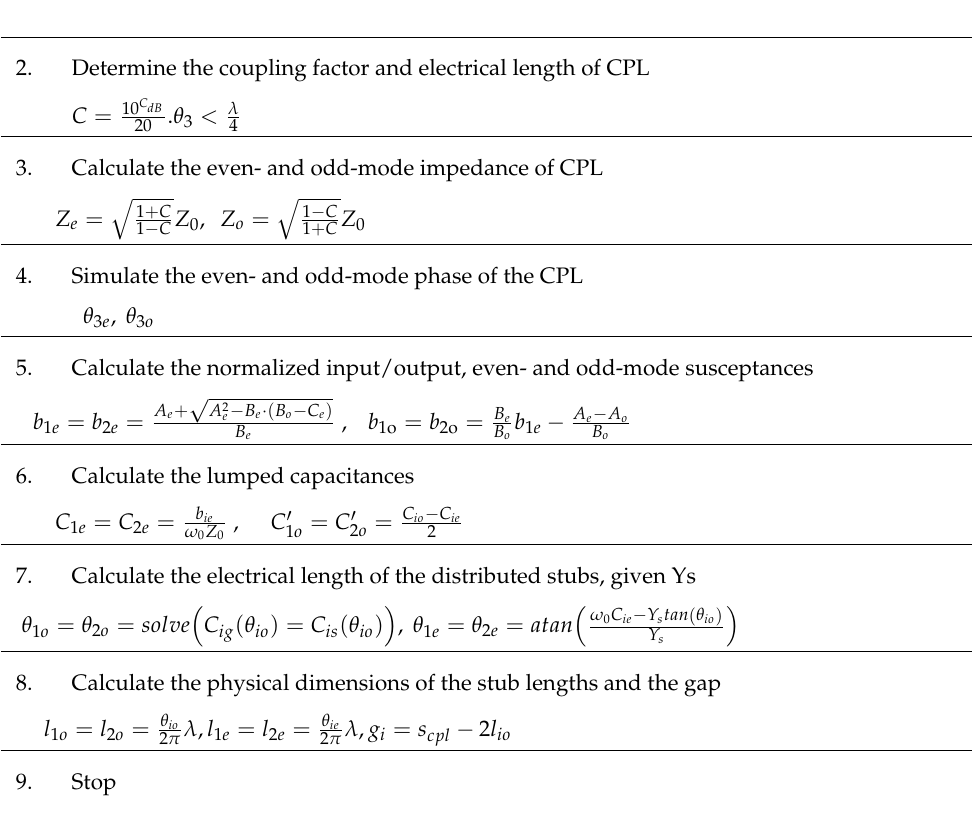
Table 1. The framework of the design